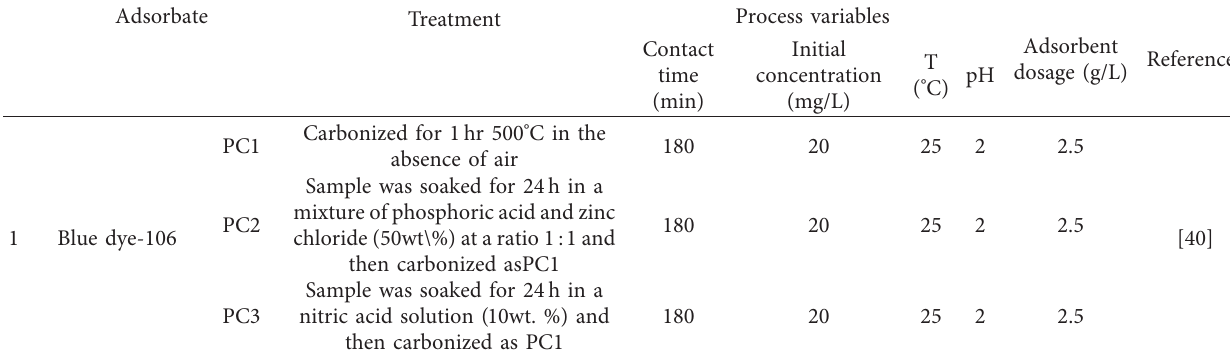
Table 3: Biosorption results of different pollutants from the literature by pomegranate peel